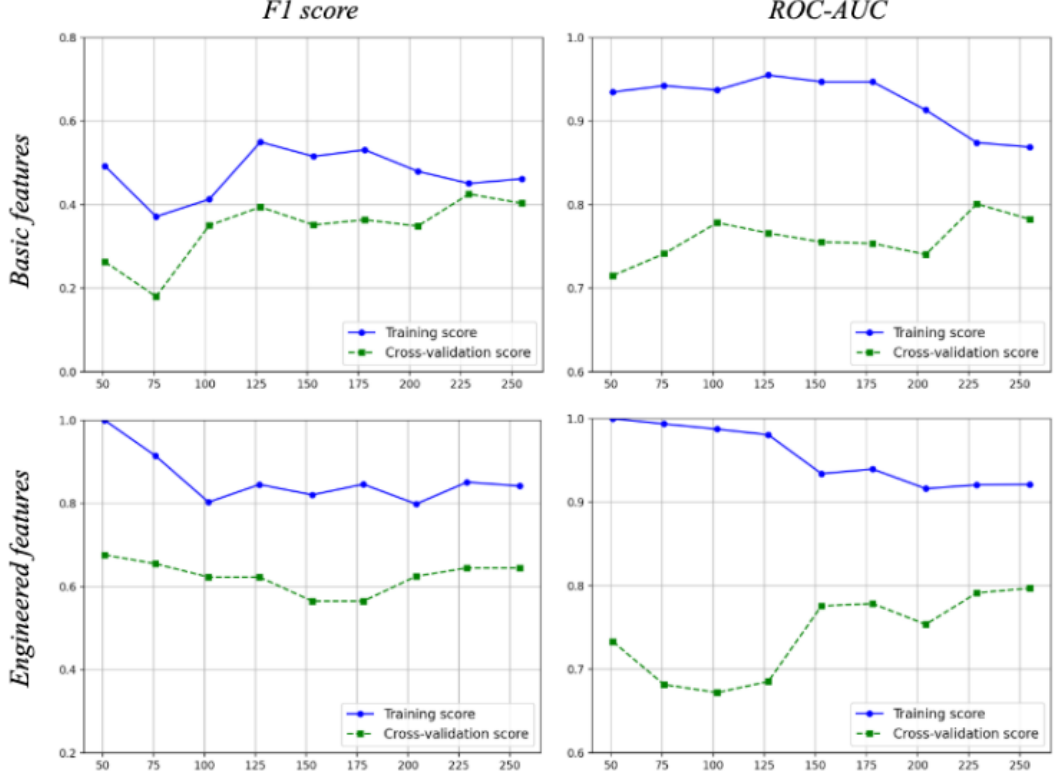
Figure 5. Learning curves of the cost-sensitive logistic regression models of the basic feature (above) set and the engineering feature set (below). Training and validation metrics are the F1-score and the ROC-AUC score (y-axis). X-axis represents the number of training instances.